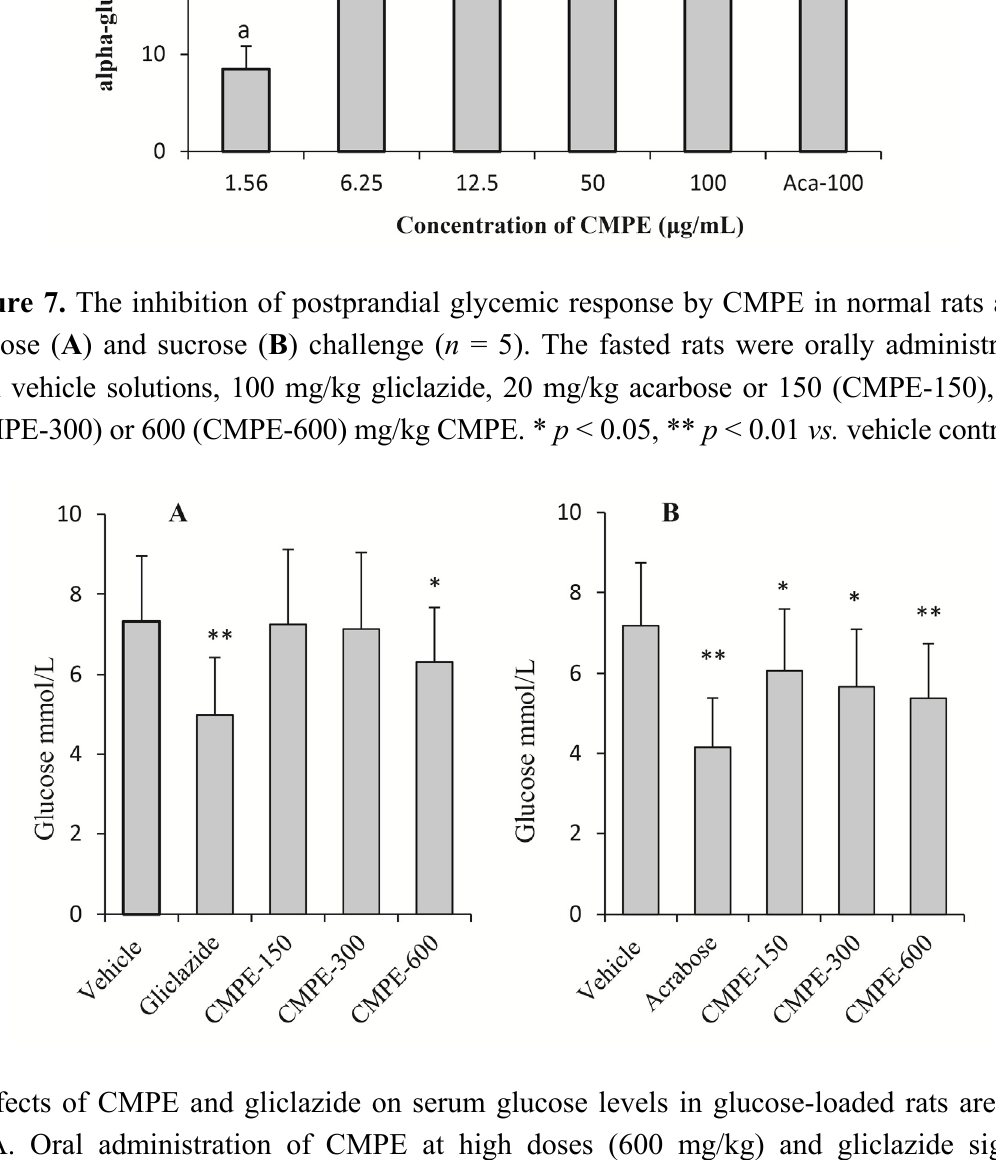
Figure 7A. Oral administration of CMPE at high doses (600 mg/kg) and gliclazide significantly reduced blood sugar 1 h after the glucose challenge. However, no significant changes in blood sugar levels were observed at doses of 150 and 300 mg/kg. These data indicate that at high doses, CMPE depresses postprandial serum levels via a mechanism linked to insulin release, similar to the mechanism by which gliclazide acts. The effects of CMPE and acarbose on serum glucose levels